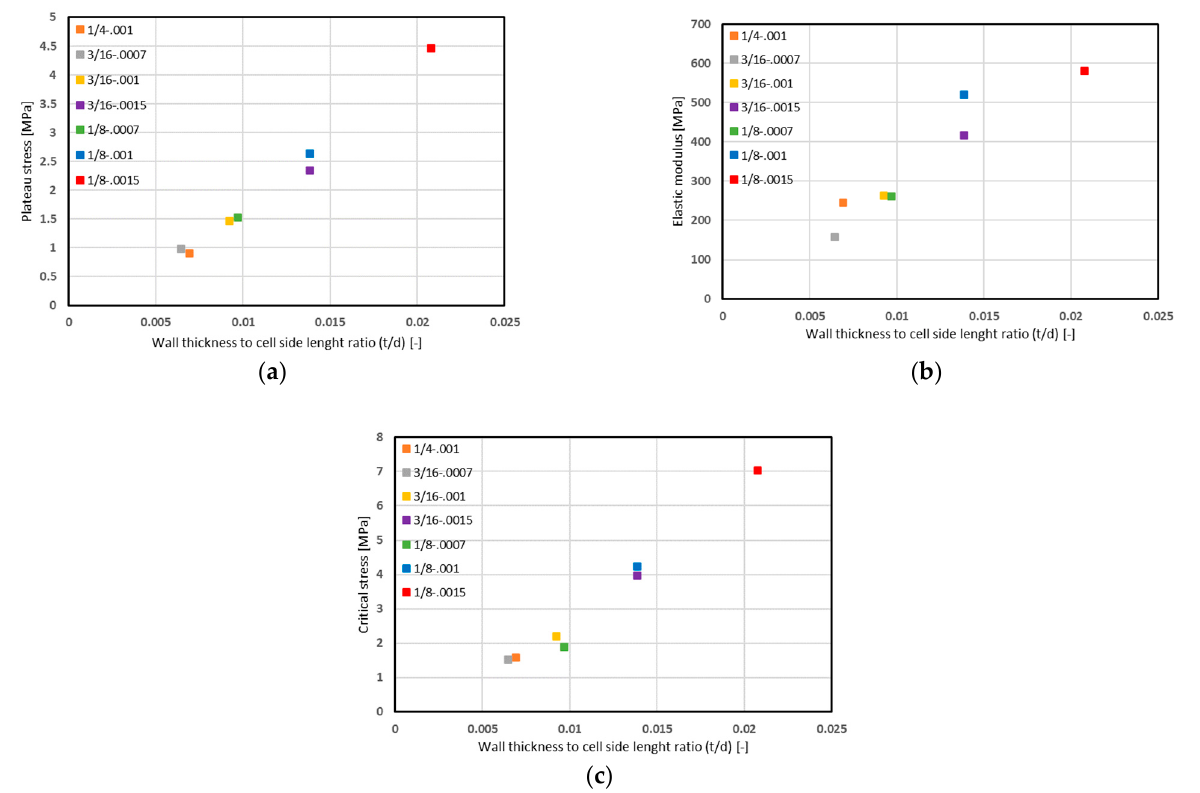
Figure 10. Relationship between ( a ) plateau stress value, ( b ) modulus of elasticity, ( c ) critical stress and ratio of wall thickness to the single core cell side length. Table 4. Summary of plateau stress values obtained during compression of all types of structures at three strain